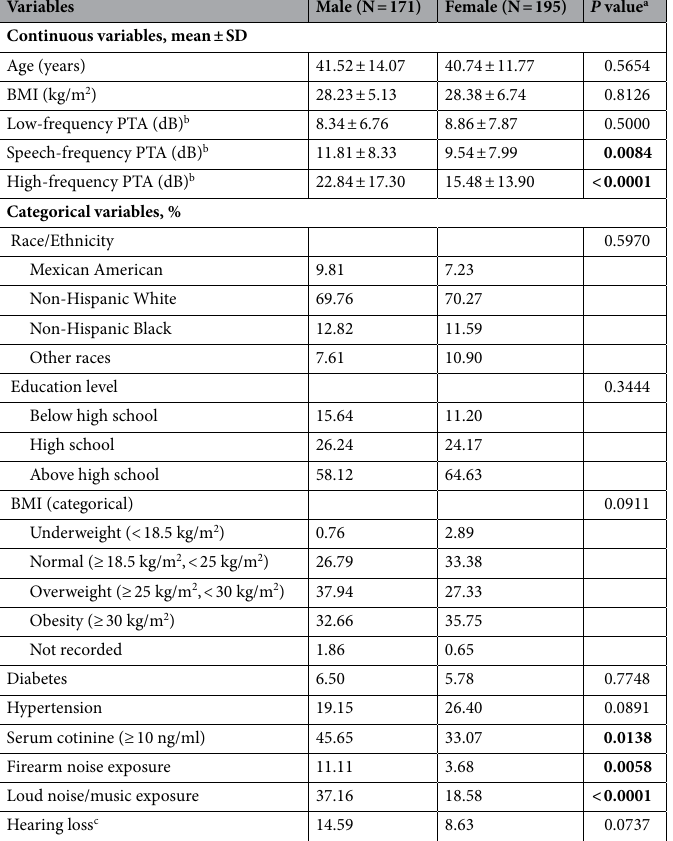
Table 1. The weighted demographic characteristics of study participants. BMI body mass index, PTA pure- tone average. a P values of continuous variables and categorical variables were calculated by weighted linear regression model and weighted chi-square test, respectively. b Low-, speech-, high-frequency PTA values in the better ear were computed from the average of hearing thresholds of 0.5, 1 and 2 kHz, 0.5, 1, 2 and 4 kHz, 4, 6 and 8 kHz, respectively. c Hearing loss was defined as the PTA value ≥ 20 dB in the better ear. Significant values are in